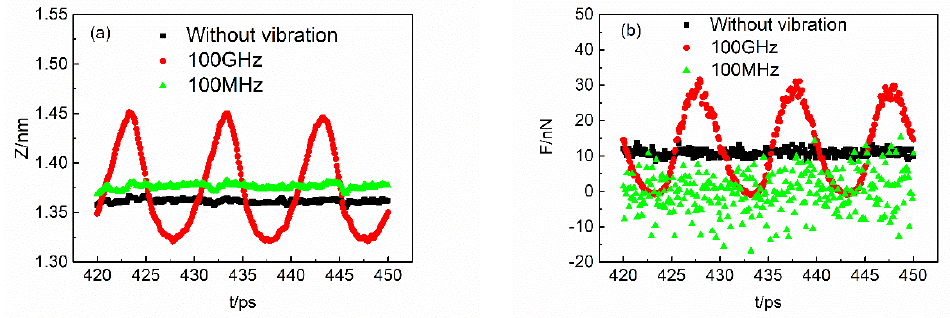
Figure 5. Interface distance and normal force of the diamond tip in three cases: the case without vibration and the cases under frequencies of 100 GHz and 100 MHz. Vibration amplitude of the virtual atom is 0.5 nm. ( a ) Interface distance with time. ( b ) Normal force in the Z direction with time.